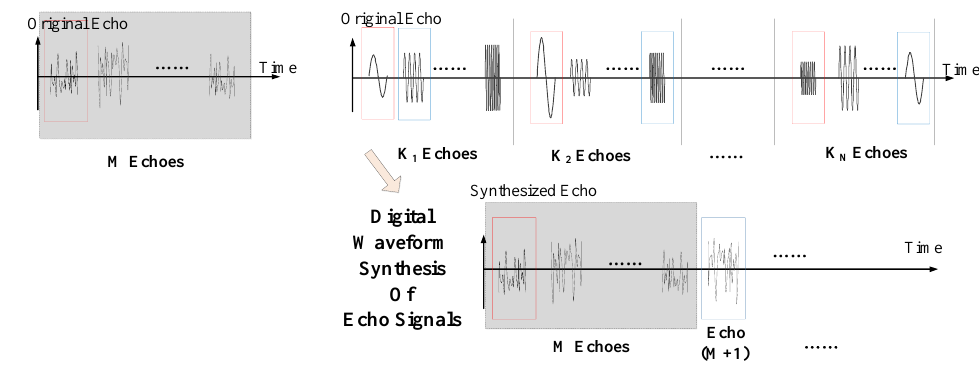
Figure 3. Comparison of random frequency hopping MSCI and time division